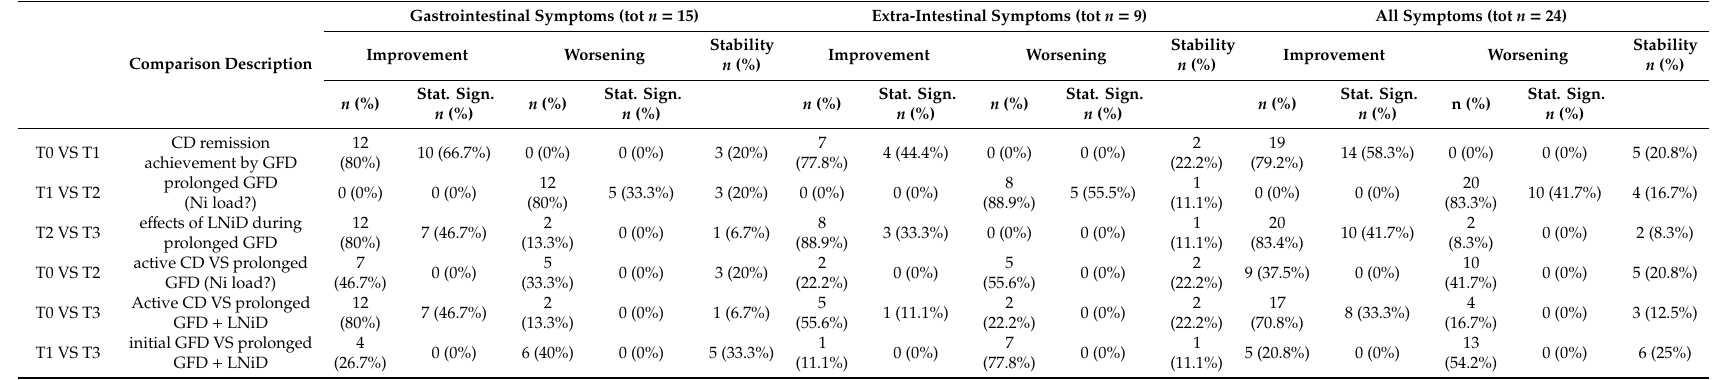
Table 1. Gastrointestinal and extra-intestinal symptoms during the di ff erent intervals analyzed. The table shows for each category of symptoms how many of them improved, worsened or remained stable in the di ff erent ranges of time considered. Data are reported in both absolute and percentage values. Legend: CD, celiac disease; GFD, gluten-free diet; LNiD, low nickel diet; n, number; Ni, Nickel; STAT. SIGN., statistically significant; tot, total; VS,